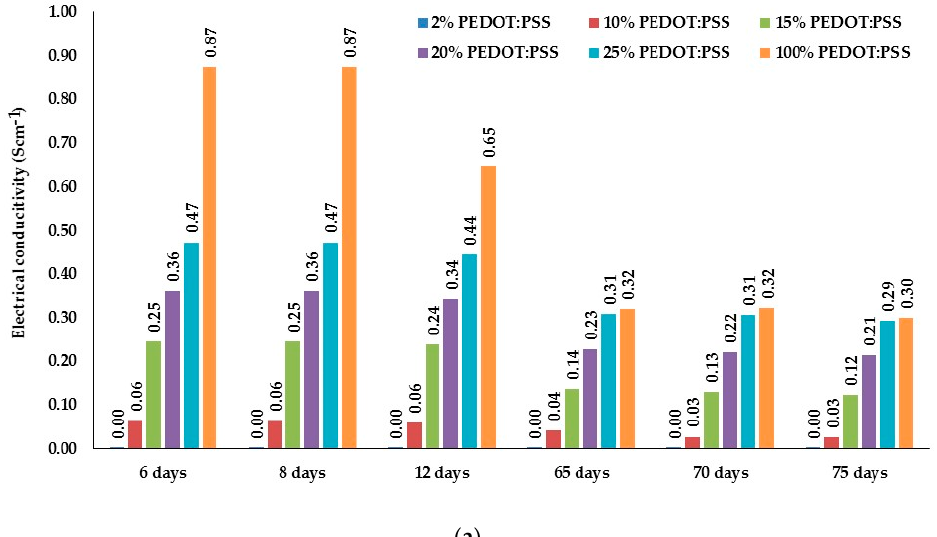
Figure 5. Percolation threshold study of PEDOT:PSS content (%) in a period of 75 days: ( a ) A/C formulation, ( b ) B/C